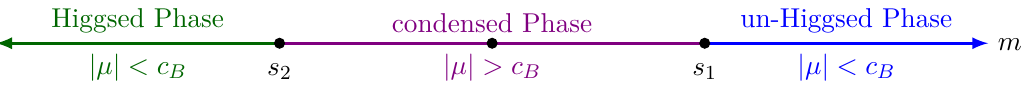
at fixed µ . At s 1 = | µ | and B (cid:0) 1 −| λ (cid:1) = −| µ | B | B | λ B |